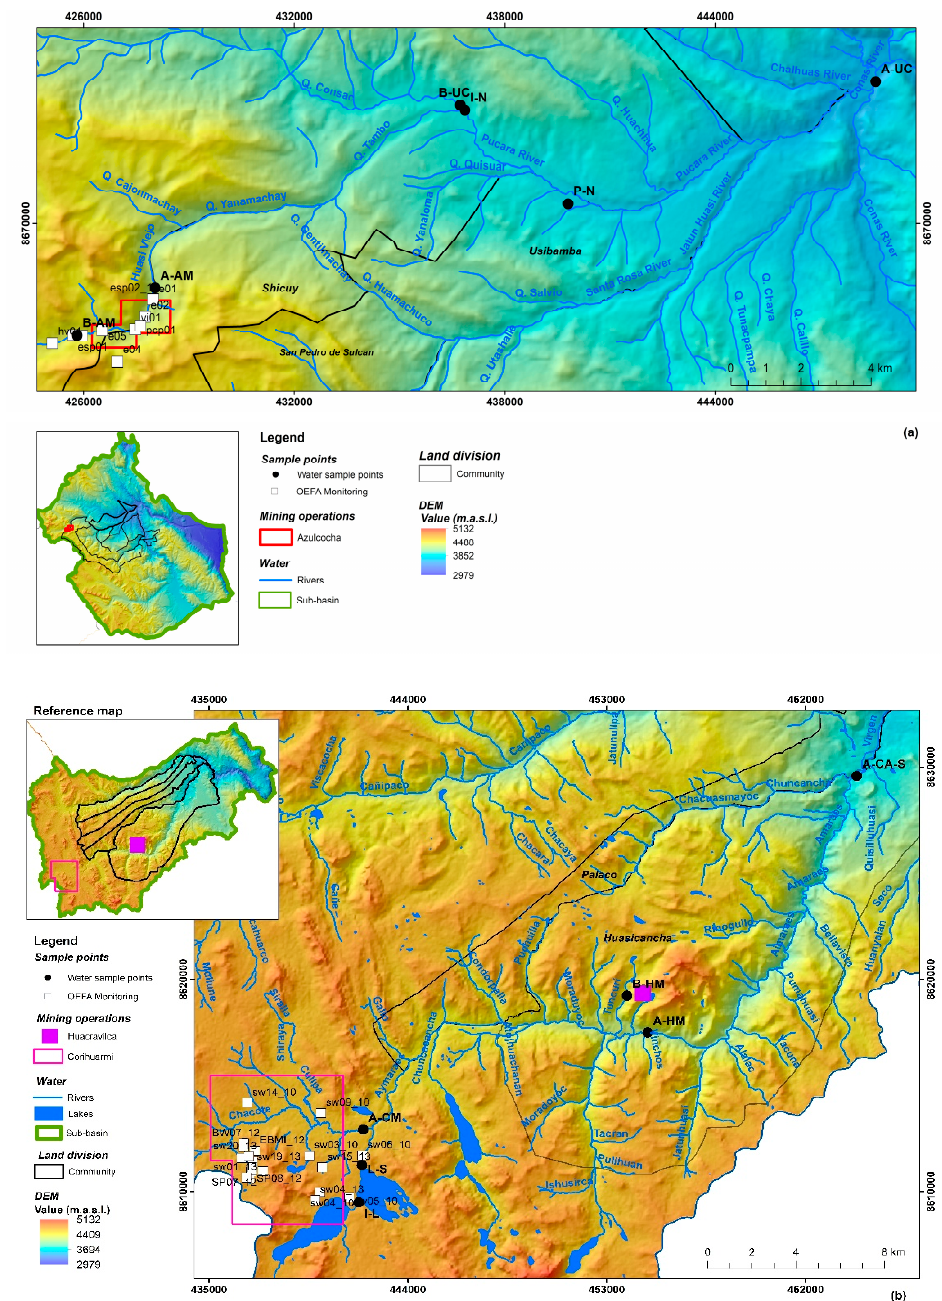
Figure 5. Water monitoring and elevation in ( a ) Cunas and ( b ) Aimaraes sub-basins (based on